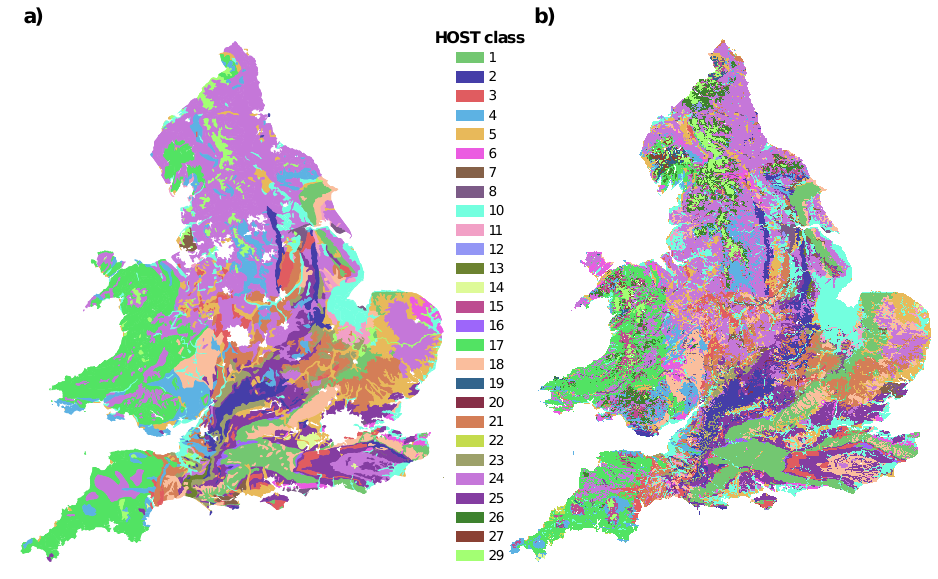
Fig. 1. Coverage of dominant HOST classes in England and Wales (a) as reclassified from the Soil Geographical Database of Europe (SGDBE) and (b) in comparison to the original HOST map. Colours for each HOST class are given in the legend. Gaps in the reclassified SGDBE are due to missing information for urban areas. Copyrights: SGDBE polygons are copyright of the Commission of the European Community, the HOST map is copyright of National Soil Resources Institute, Cranfield University, UK and the Centre for Ecology & Hydrology, Swindon,